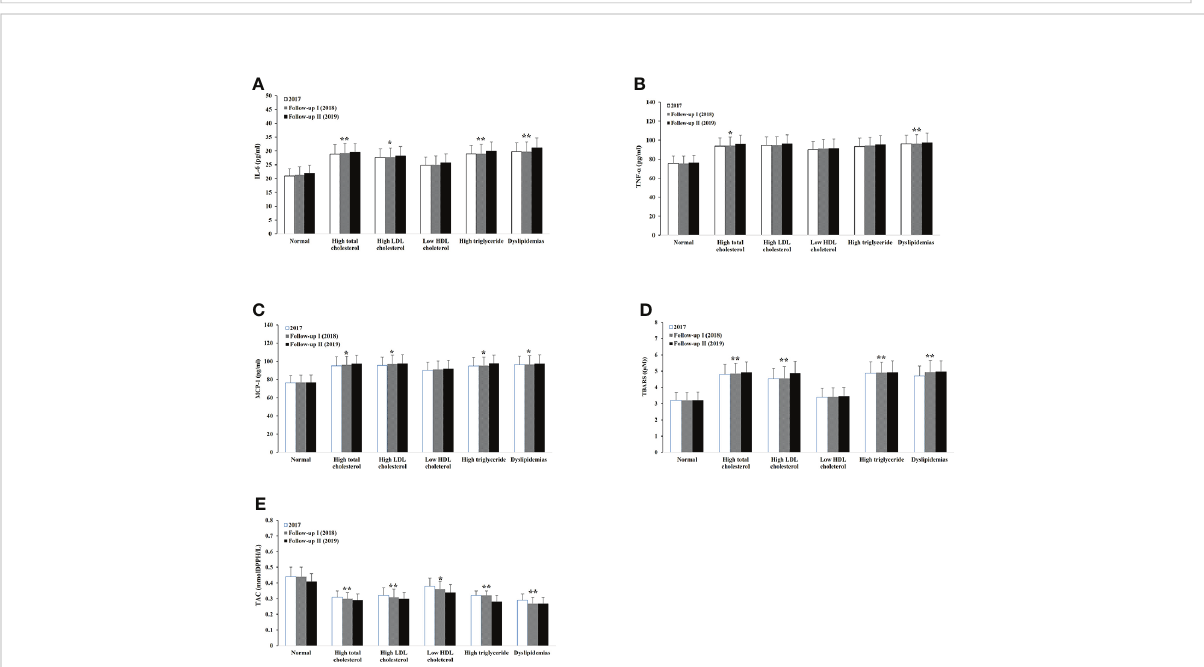
FIGURE 4 Serum levels of proin fl ammatory cytokines, oxidative stress, and antioxidant capacity within different lipid abnormalities among female adults. IL-6 (A) , TNF- b (B) , MCP-1 (C) , TBARS (D) , and TAC (E) . Logistic regression analysis indicated: * p < 0.05, ** p < 0.01, overall difference vs. the level of lipid normal